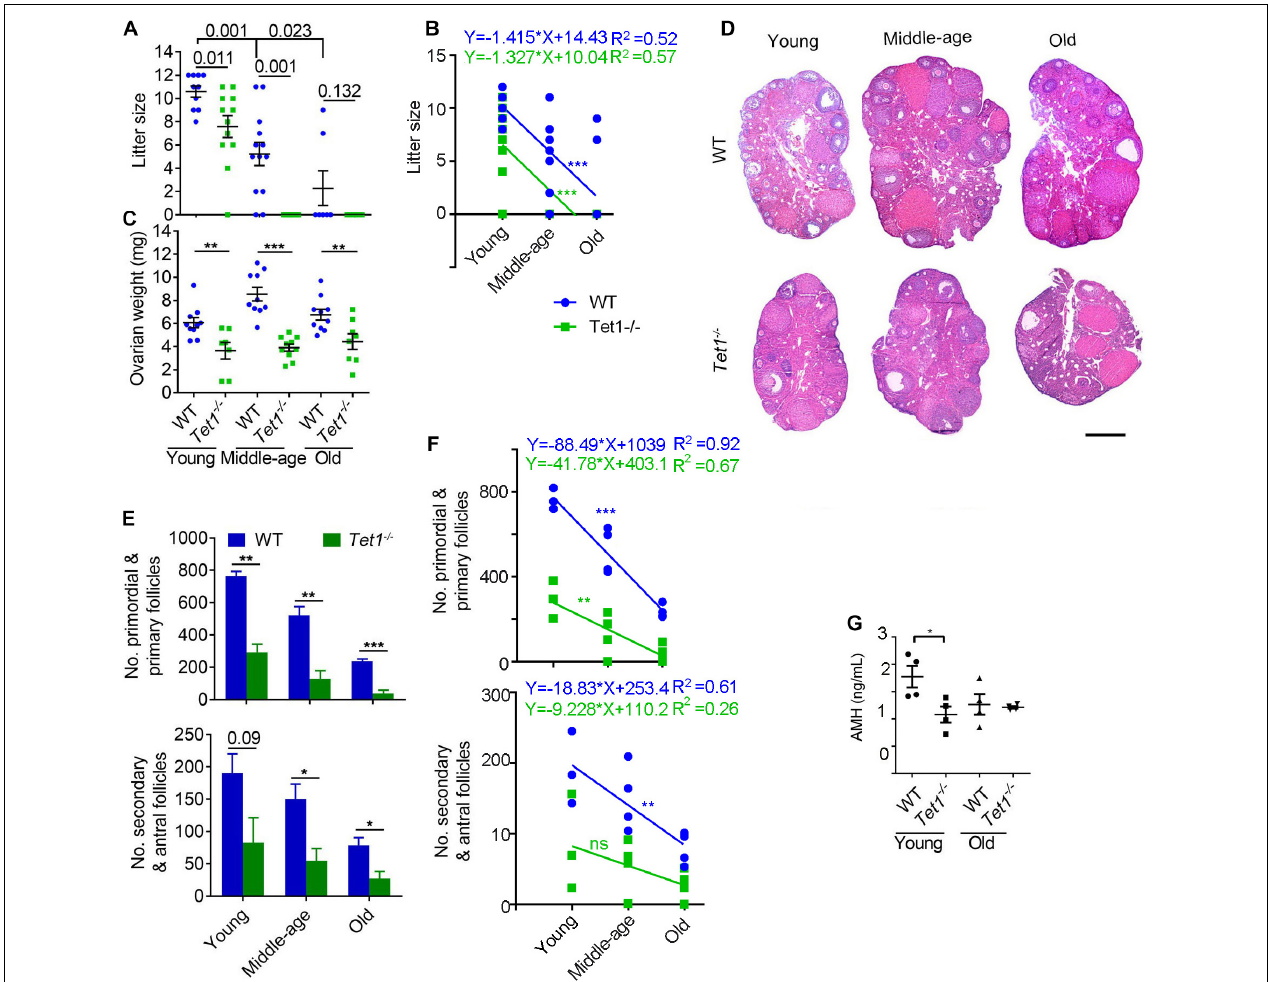
FIGURE 1 | Tet1 knockout causes subfertility and premature ovarian failure. (A) Average litter size of wild-type (WT) and Tet1 knockout ( Tet1 − / − ) female mice at three different reproductive age (young, 2–4 months; middle-age, 7–9 months; old, 10–12 months). n > 10 mice for young and middle-age group and n = 7–8 mice for old group. (B) Linear regression analysis of the age effects on litter size between WT and Tet1 − / − mice. n > 10 mice for young and middle-age group and n = 7–8 mice for old group. (C) Average weight per ovary from WT and Tet1 − / − mice. n > 7. (D) Representative images of hematoxylin and eosin (H&E) staining of ovarian sections from young, middle-age and old groups. Scale bar, 500 µ m. (E) Number of primordial and primary follicles, or secondary and antral follicles from WT and Tet1 − / − mice. n = 4-6. (F) Linear regression analysis of the age effects on the number of follicles between WT and Tet1 − / − mice. n = 3-4. ns, no significant difference. (G) AMH levels in serum of WT and Tet1 − / − mice by ELISA assay ( n = 4). The bars show mean ± SEM. * P < 0.05; ** P < 0.01; *** P < 0.001. The P value is labeled if P > 0.05 (A,E)